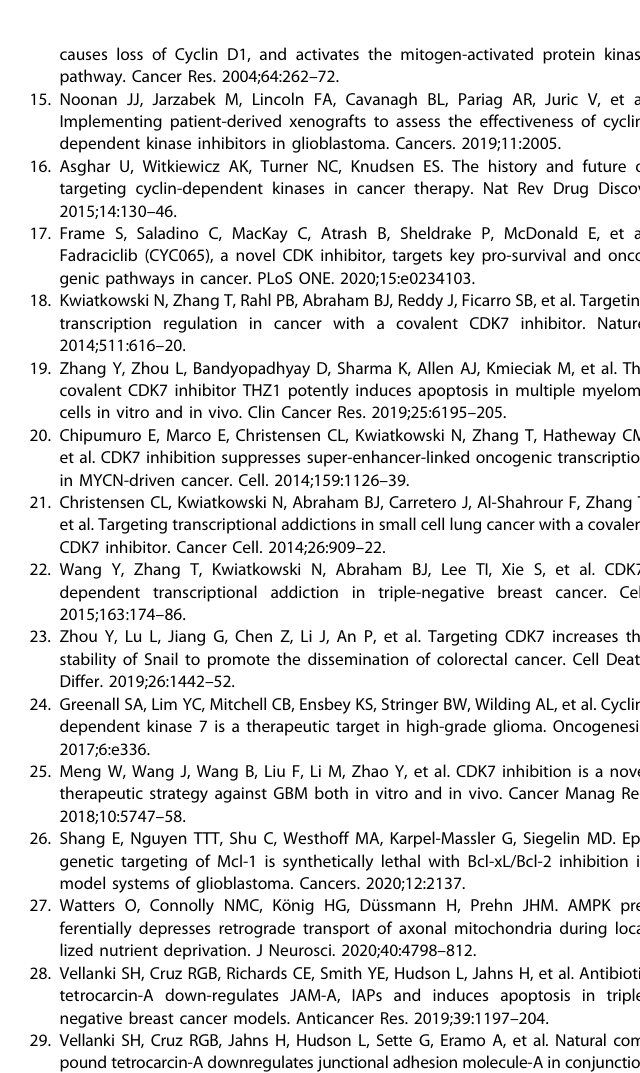
Fig. 6 Schematic representation of cell cycle arrest and apoptotic cell death induced in CKI-sensitive cells using CYC065 and THZ1. Cell cycle progression and transcription are under the control of multiple CDKs and their associated cyclins. The CDK1/-cyclin B1 complex is necessary for the progression of the cells through the G2/M phase of the cell cycle. CDK7 is one of the main kinases required for CDK1/cyclin B complex formation and activation during the G2/M transition of the cell cycle. Failed activation of CDK1/cyclin B complex causes cell cycle arrest in the G2/M phase. Both CYC065 and THZ1 affect the CDK1/cyclin B1 complex formation, stalling cell cycle progression at the G2/M phase of the cell cycle. On the other hand, phosphorylation of the CTD of RNAP II by CDK7/cyclin H and CDK9/cyclin T complexes leads to transcription initiation and elongation, respectively. In addition, the CDK9/cyclin T complex is under the direct control of CDK7, and both are necessary for successful transcription. Inhibition of CDK9 and 7 by CYC065 and THZ1, respectively inhibit transcription through dephosphorylation of Ser2/5 on CTD of RNAPII, ultimately leading to downregulation of short-lived mRNAs such as Mcl-1. This releases pro- apoptotic Bim which triggers multiple reactions leading to mitochondrial membrane permeabilization (MOMP) and subsequent executioner caspase activation followed by apoptosis